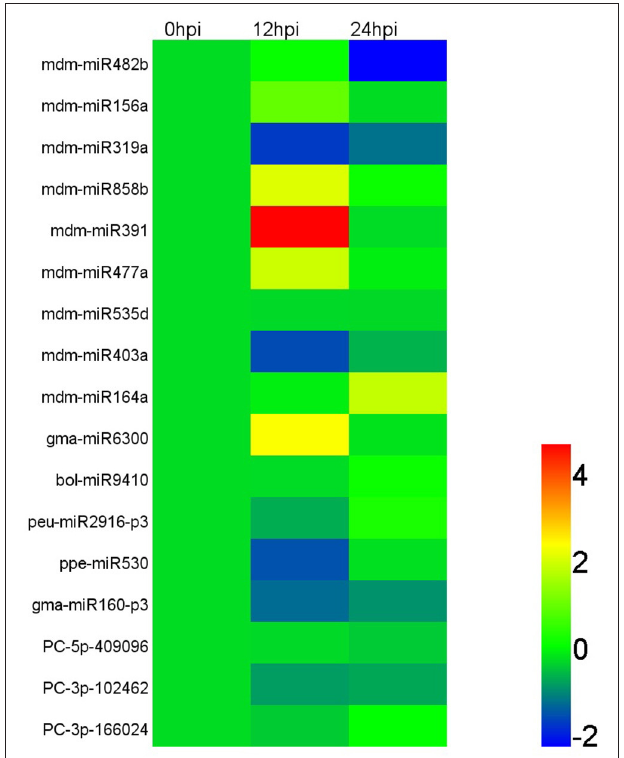
FIGURE 4 | Relative expression of miRNAs in apple twig bark tissue— V. mali interaction. According to the sequencing read number, 17 miRNAs were selected for transcript accumulation analysis in apple twig bark tissue after challenge with V. mali (12 and 48 hpi). The relative expression level of the miRNAs in the V. mali -inoculated plants at each time point was calculated as the fold-change of the mock-inoculated plants at that time point using the comparative 2 − 11 CT method. The value of Log2 fold-change is used to construct the heat map. Different colors indicate the relative expression level of different miRNAs during the infection progress of Vm to apple twigs.